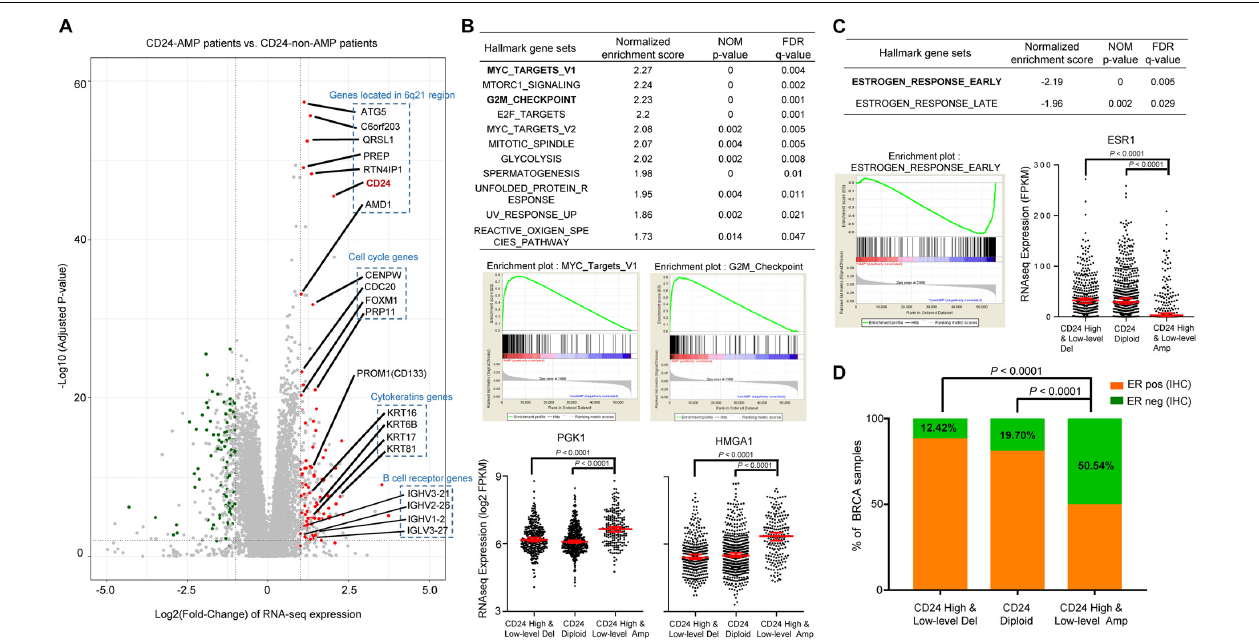
FIGURE 3 | CD24 amplification correlated with cell cycle and estrogen response activity. (A) Volcano plot of mRNA expressions change between BRCA samples harboring CD24 -amplification and non- CD24 -amplification. The x -axis specifies the fold-changes (FC) and the y -axis specifies the negative logarithm to the base 10 of the adjusted p -values. Gray vertical and horizontal dashed lines reflect the filtering criteria. Red and green dots represent genes expressed at significantly higher ( n = ◦ 79) or lower ( n = ◦ 68) levels, respectively. The genes located in the 6q21 chromosomal region and enriched in functional patterns are highlighted. (B) GSEA comparing gene-expression signatures of TCGA breast tumors with the CD24 -amplification and non- CD24 -amplification. GSEA positive result table (top) showing significant enrichment ( FDR < 0.05) of the hallmark gene sets from MSigDB. The enrichment plot on the middle left (right, respectively) shows the distribution of MYC targets (G2M checkpoint, respectively) genes that are positively correlated with the CD24 -amplification phenotype. The distribution plot on the bottom shows the marker genes ( PGK1 and HMGA1 ) expression difference among BRCA patients with different CD24 copy number status. (C) GSEA negative association table (top) showing significant enrichment ( FDR < 0.05) of the hallmark gene sets from MSigDB. The enrichment plot on the bottom left shows the distribution of estrogen response early genes that are negatively correlated with the CD24 -amplification phenotype. The distribution plot on the bottom right shows the marker genes ( ESR1 ) expression difference among BRCA patients with different CD24 copy number status. (D) Distribution of ER-negative (based on IHC) samples among different CD24 copy number groups shows the patients with CD24 -amplification are enriched in ER-negative status. Normalized enrichment score (NES) and FDR q -value of GSEA are shown in panels (B,C) . Statistical significance was determined by the One-way ANOVA in panels (B,C) , and the exact Fisher’s test in panel (D)